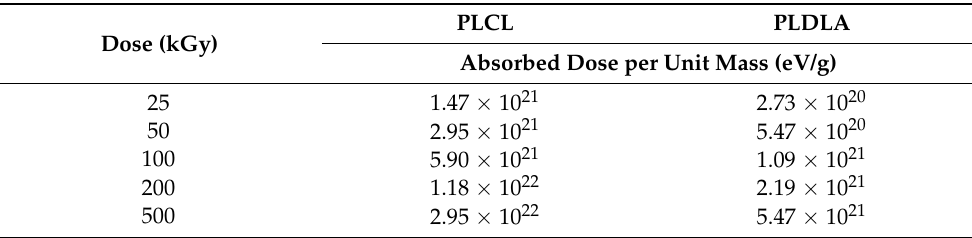
Table 1. Absorbed dose per unit mass of PLCL and PLDLA models according to gamma radiation dose.